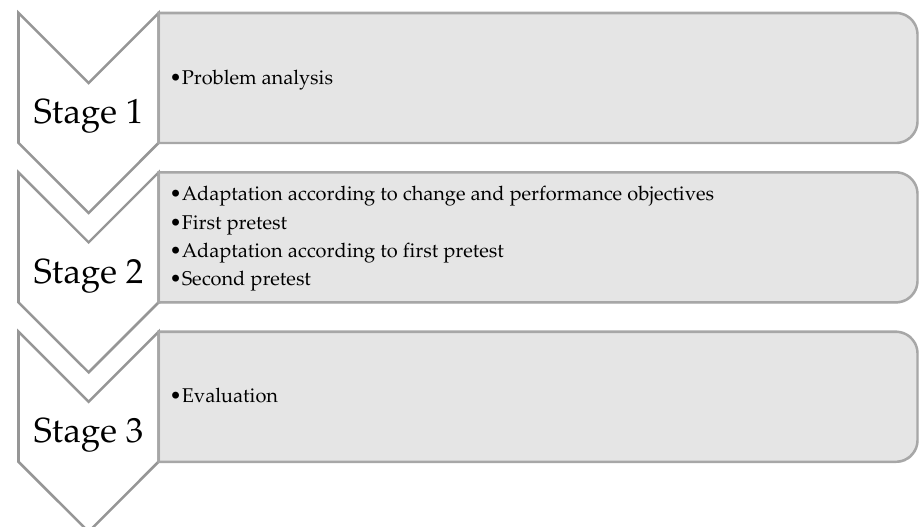
Figure 1. Three stages of systematic development of written invitational material.